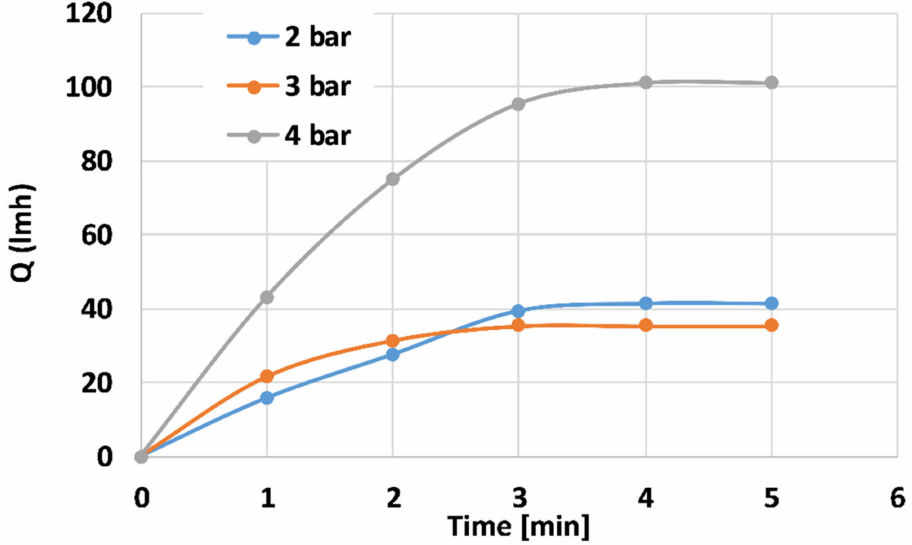
Figure 8. Distilled water flux properties of the 100 mL PANI-coated CNT membranes at di ff erent